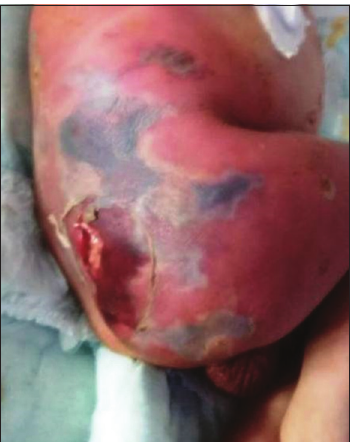
Figure 1: Erythematous, edematous, violaceous colored area over the left lower back extending to buttock